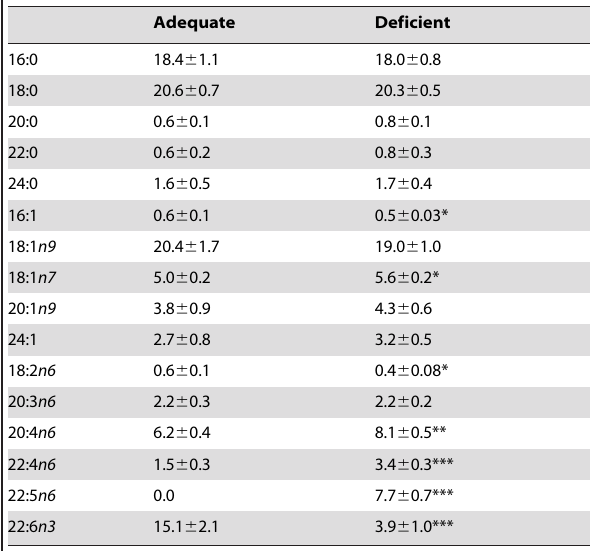
Table 2. Fatty acid analysis using the cerebellum of TBI mice on omega-3 fatty acid adequate or deficient diet (n =4)